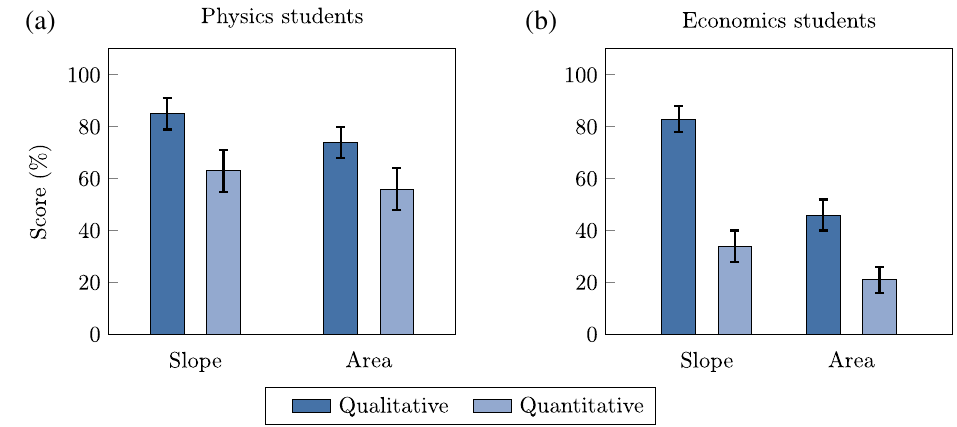
FIG. 3. Average scores of (a) physics students and (b) economics students on the qualitative and quantitative questions about graph slope and the area under a graph. The error bars represent 1 standard error of the mean (SEM).